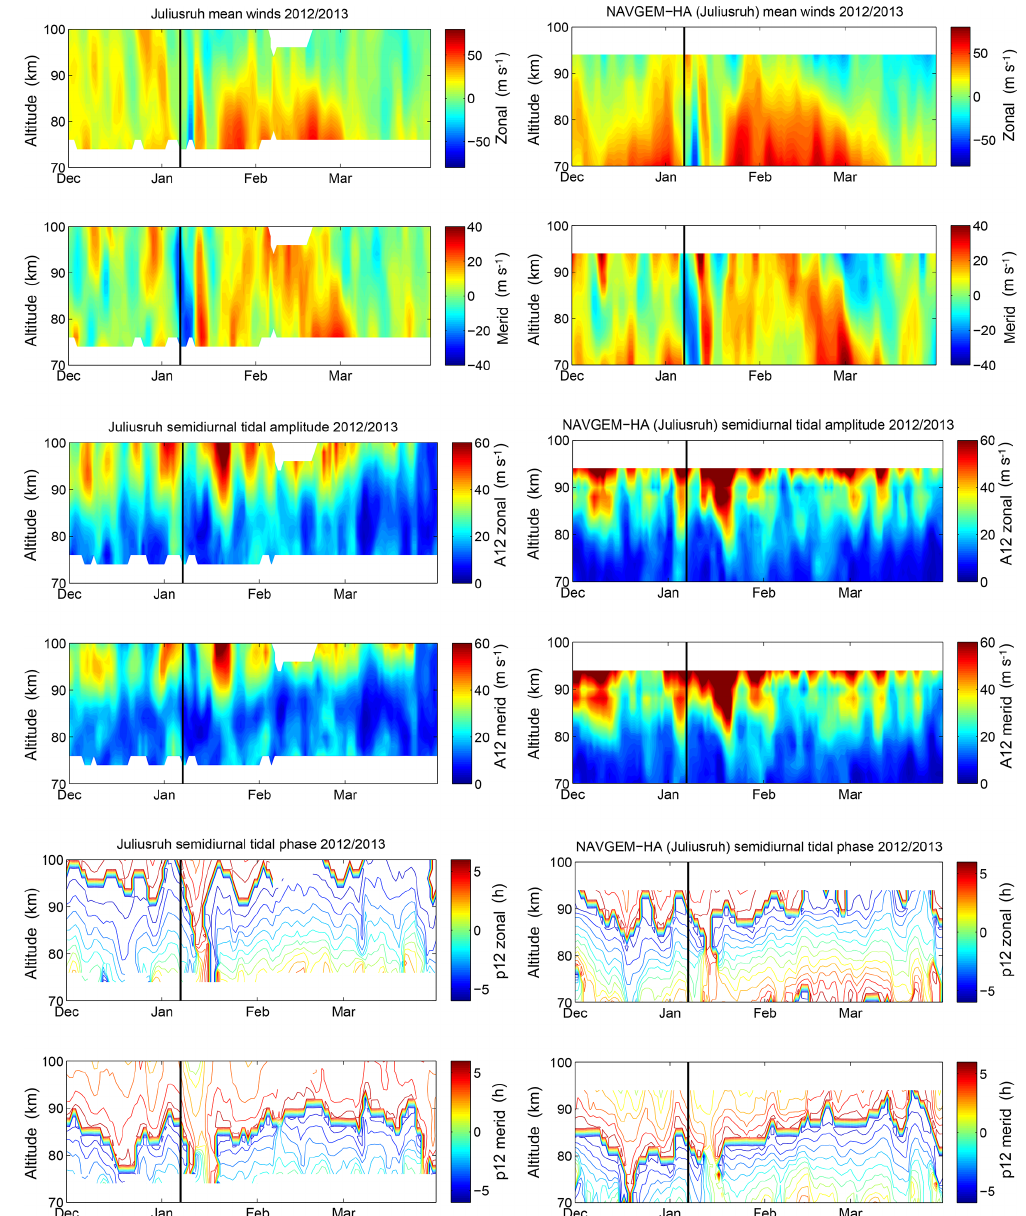
Figure 10. The same as Fig. 9 but for